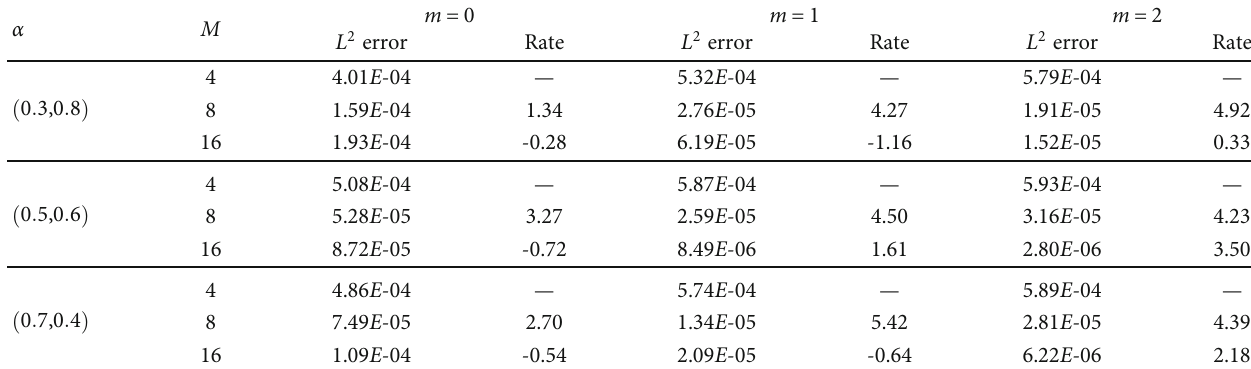
Table 4: The L 2 -norm errors in space for nonsmooth case in Example 1 with τ = T /8000